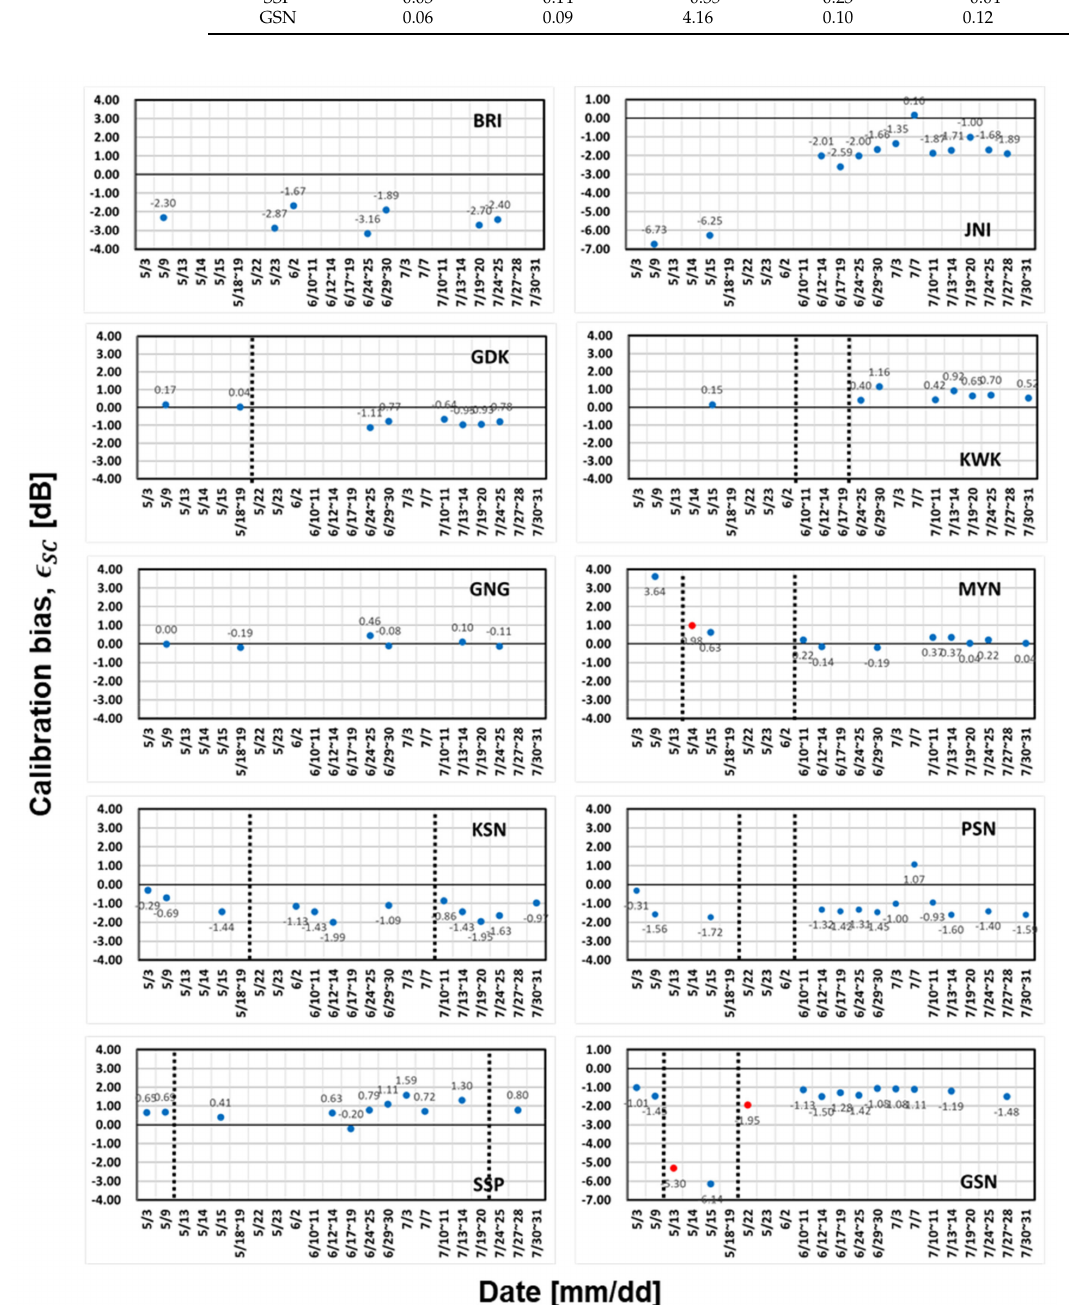
Figure 7. Time series of radar absolute calibration bias estimated from SC (blue dot) and change in the RCA (red dot) at each radar site from 1 May 2020 to 31 July 2020. The vertical dotted lines represent the period with similar RCA (P1, P2 and P3) shown in Figure